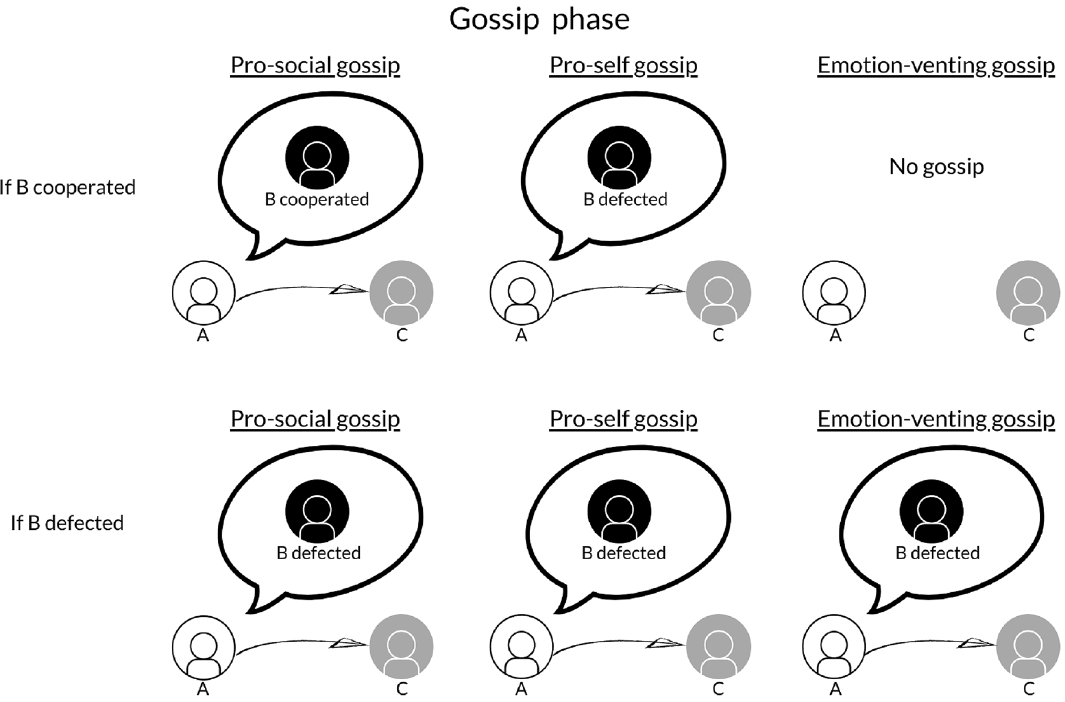
Figure 2. Gossip motives studied in the model. In the Figure, A gossips about B (its previous interaction partner) to C. The content of the gossip depends on A’s gossip motive and B’s behavior in the previous happened in their previous interaction, thus protecting their current partner from exploitative behaviors (if the previous partner defected) and encouraging and sustaining cooperative interactions (if the previous partner cooperated). Agents motivated by the desire to increase their own reputation or relative standing in the group, in contrast, should only report that previous partners behaved uncooperatively. Therefore, we modelled “pro-self” gossipers as agents that always report defective behavior of their previous partner, decreasing their reputations in the eye of the receiver. As negative events are weighted more than positive ones, moreover, agents gossiping because they need to vent their emotions should particularly share negative information (i.e., information about uncooperative interactions). Hence, we modelled “emotion-venting” gossipers as agents that share informa- tion about previous partners’ uncooperative behavior to release the tension deriving from a previous negative experience. As positive events do not evoke strong negative feelings that need to be vented, however, they do not share any information if the previous partner cooperated. The social enjoyment motive does not elicit any clear behavioral pattern: People may share both positive and negative, truthful and false information about the person they gossip about, without any strategic reason. As we focus in the model on the motives that have the clearest behavioral implications, we did not include the social enjoyment motive. Moreover, we examined the impact of gossip motives under different conditions. Specifically, we varied: 1) the way in which agents are matched with their partners, and 2) the way in which agents react to the reputational information. With regard to how agents chose their partners, we modelled two scenarios (see SI, section S1.3): (I) agents were randomly matched in each round, mimicking a real-life situation in which individuals are paired up by a third party to complete a task, such as for example could be the case for individuals working in an organization and paired into work dyads by a supervisor; and (II) agents chose their partner in each round based on the repu- tational information they have about their group members. This scenario mirrors a real-life situation in which individuals use the reputational information to select cooperators and avoid defectors. A large branch of the literature has examined how cooperation evolves depending on how individuals update their behaviors based on the information received 35,36 . In the extensive literature on games and strategies, the most frequent behavioral rules (apart from those that are purely cooperative/defective) whereby agents use the information gathered to form a reputation and act upon it 37 share two core features: forgiveness and leniency 38,39 . Hence, we modelled two behavioral rules (see “Methods” and SI, section S1.2): (a) the conditional cooperation rule, in which agents are more likely to cooperate if their partner previously cooperated and vice-versa; and (b)